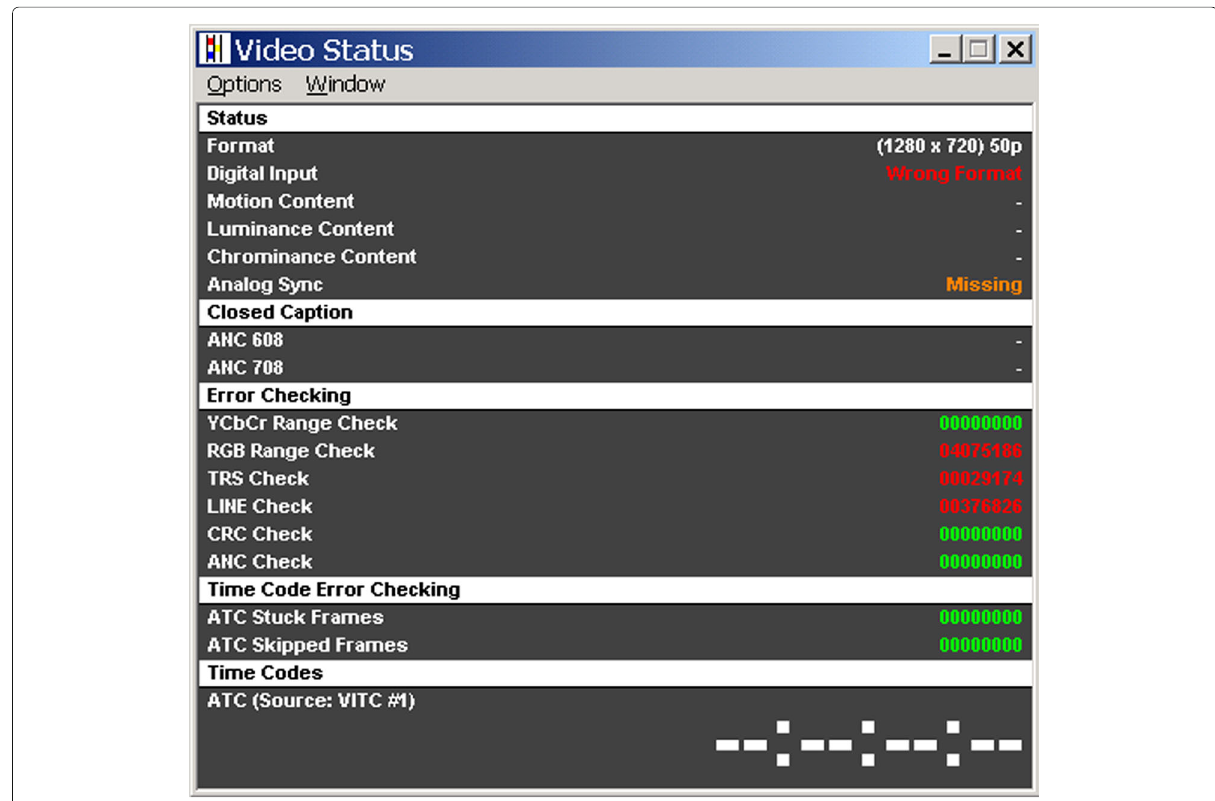
Fig. 11 Output from the Omnitek video